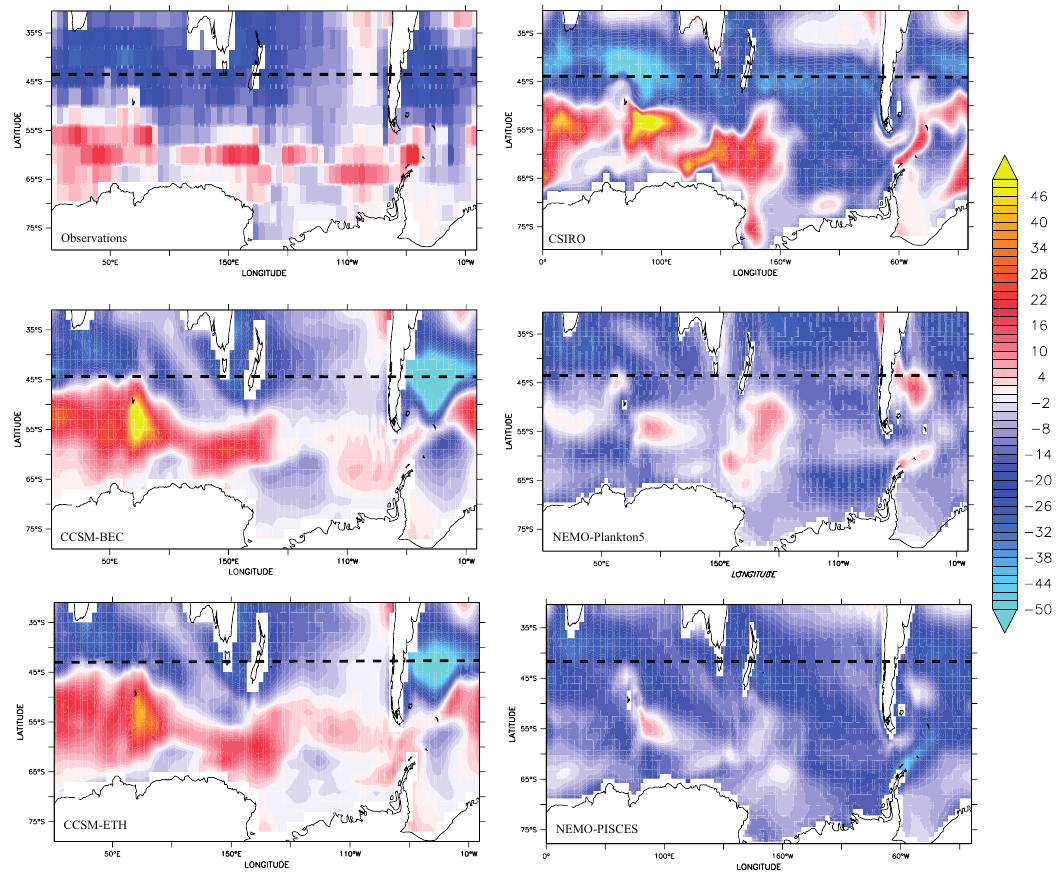
Fig. 4. Spatial maps of the annual mean uptake, in gCm − 2 yr − 1 from the five ocean biogeochemical models and observations; negative Figure 4 Spatial maps of the annual mean uptake, in gC/m 2 /yr, from the five ocean 1212$ values reflect fluxes into the ocean. The dashed line represents the RECCAP boundary at 44 ◦ S. biogeochemical models and observations; negative values reflect fluxes into the 1213$ ocean. The dashed line represents the RECCAP boundary at 44 ° S 1214$